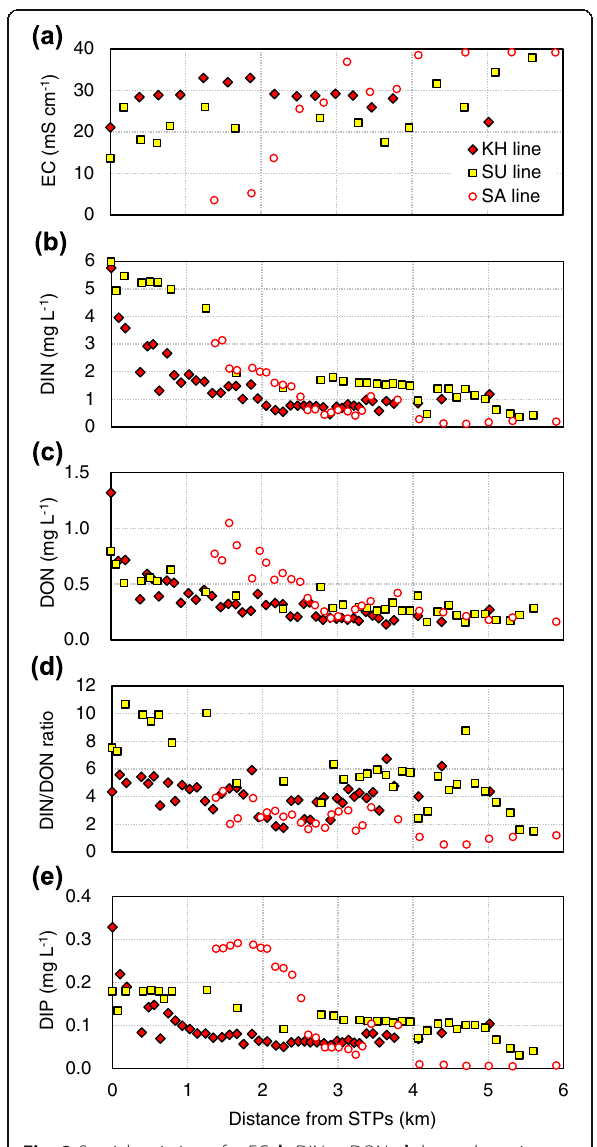
Fig. 2 Spatial variation of a EC, b DIN, c DON, d the molar ratio between DIN and DON (DIN/DON), and e DIP in the surface seawater on the SU line in August and the KH and SA lines in October